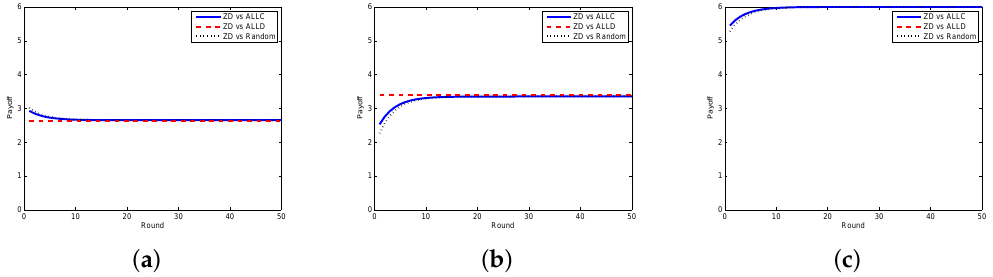
Figure 8. Payoffs with ZD vs. ALLC/ALLD/Random in the continuous model. ( a ) requestor’s payoff; ( b ) worker’s payoff; ( c ) social welfare.